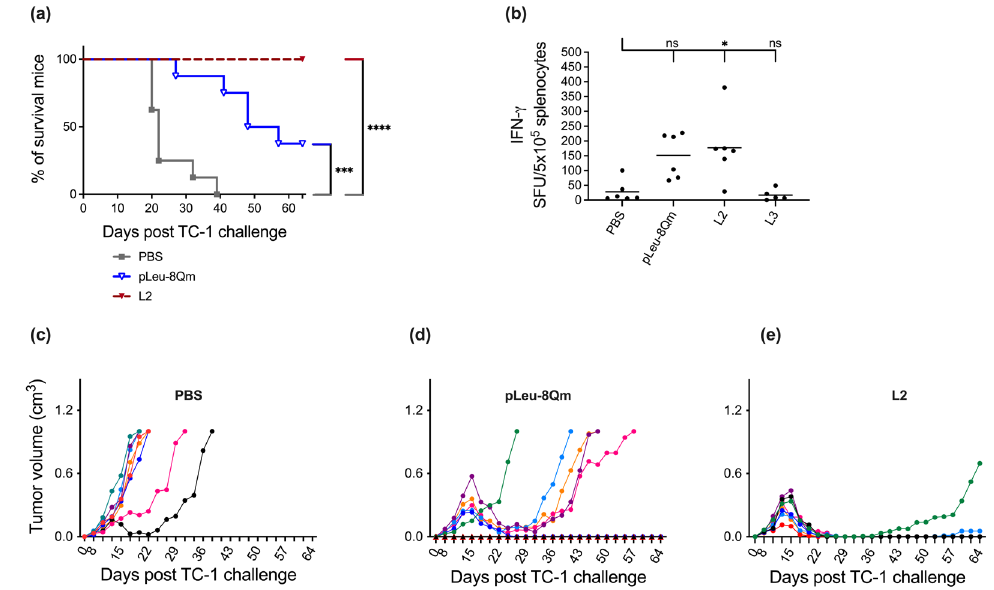
Figure 2. In vivo tumor treatment experiments and CD8+ T-cell activation. C57BL/6 mice (n = 8 mice/group) were inoculated subcutaneously with TC-1 tumor cells (day 0) and vaccinated with different immunogens on day 7. ( a ) Survival rate was monitored and time to death plotted on a Kaplan–Meier survival curve. Tumor volume was monitored and plotted for each individual mouse immunized with ( b ) PBS; ( c ) pLeu-8Qm ; ( d ) L2 . The survival rate of each group was compared with the negative control (PBS) and was analyzed using the log-rank (Mantel–Cox) test (*** p < 0.001; **** p < 0.0001). ( e ) Assessment of CD8+ T-cell responses in mice subcutaneously immunized with the vaccine candidates. Mouse spleens were harvested ten days after vaccination and IFN- γ